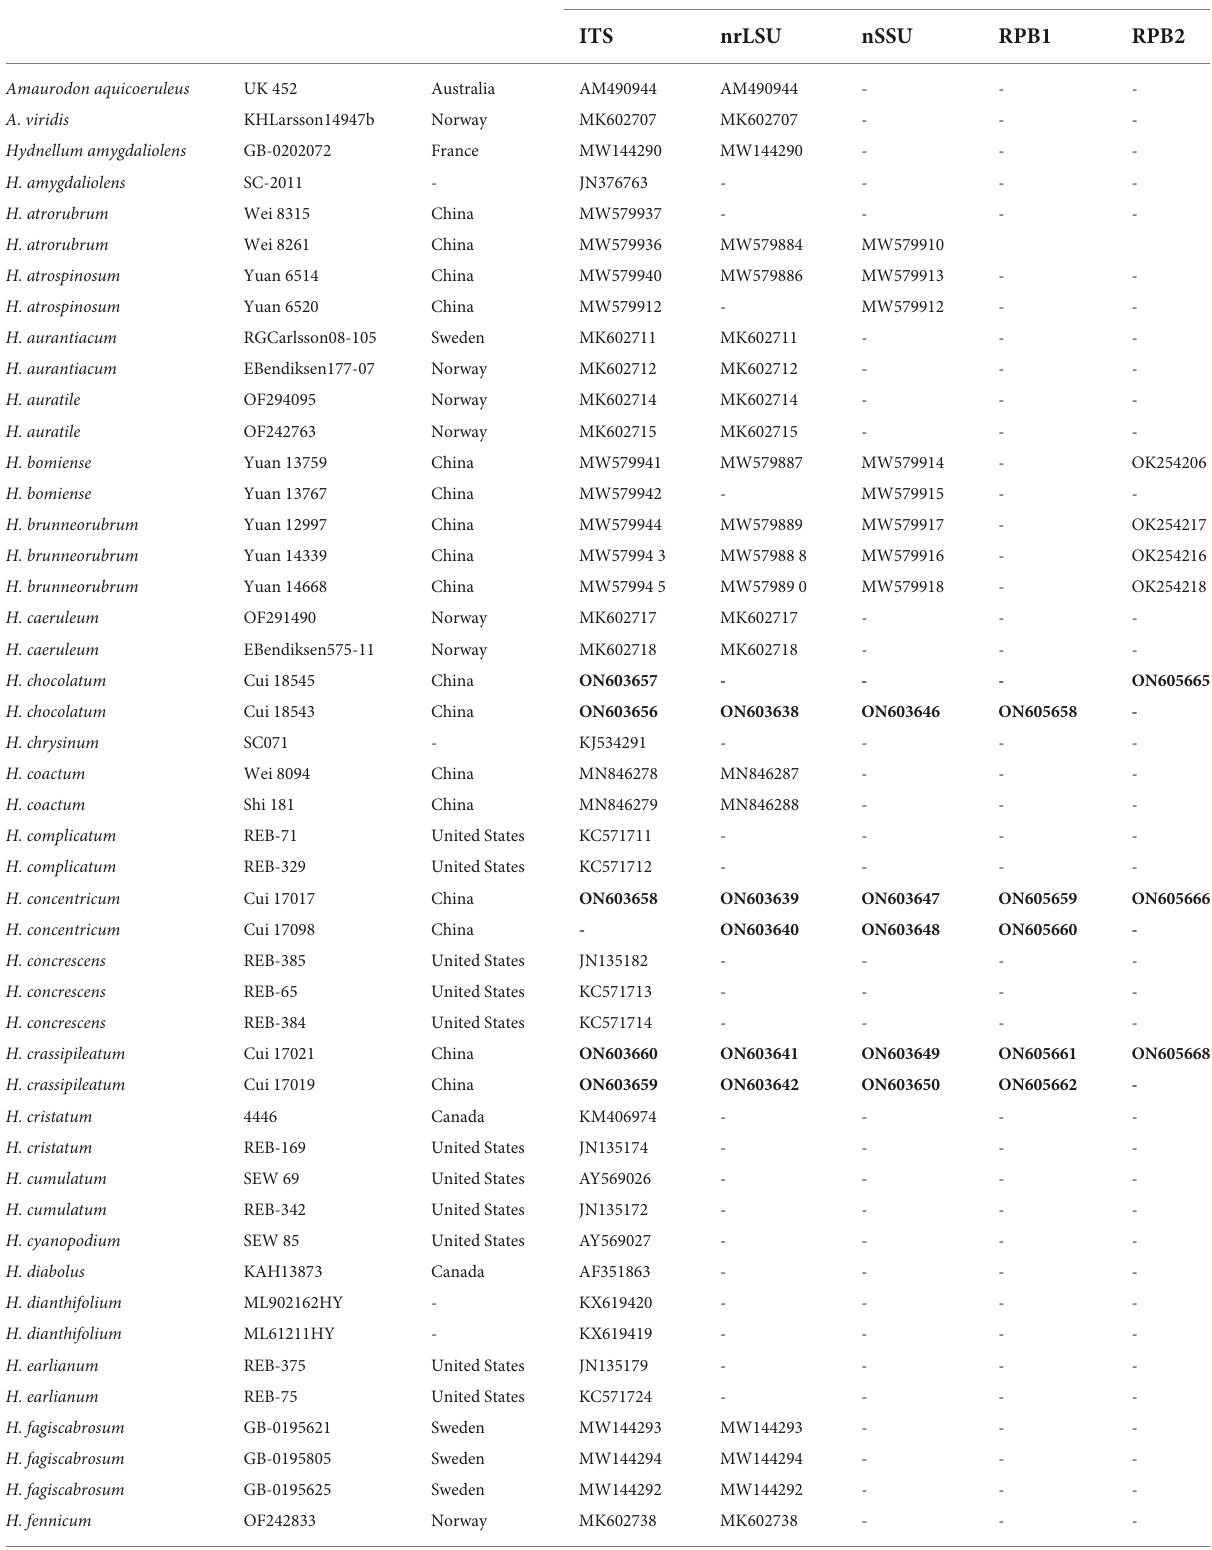
TABLE 1 A list of species, specimens, and GenBank accession numbers of sequences used in this study. Species Specimen